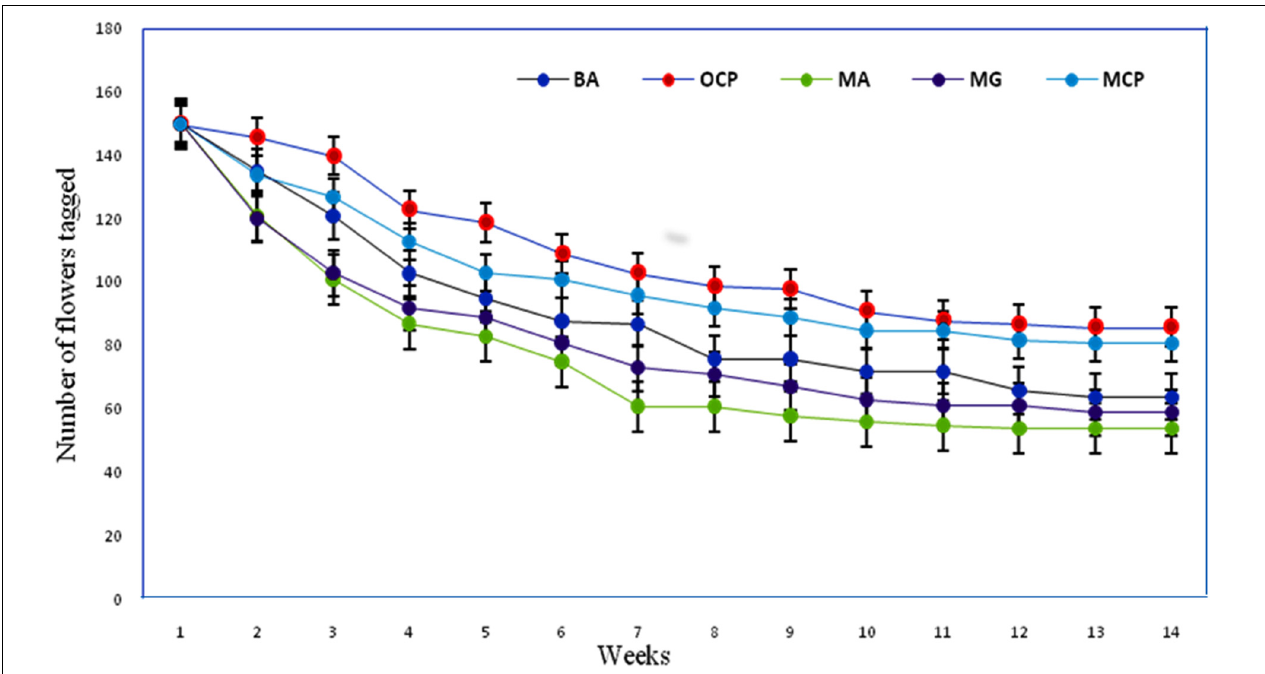
FIGURE 8 | Percentage of fruit survival in R. webbianum after different manual treatments BA, bagged for autogamy; OCP, open cross-pollination; MA, manual autogamy; MG, manual geitonogamy; MCP, manual